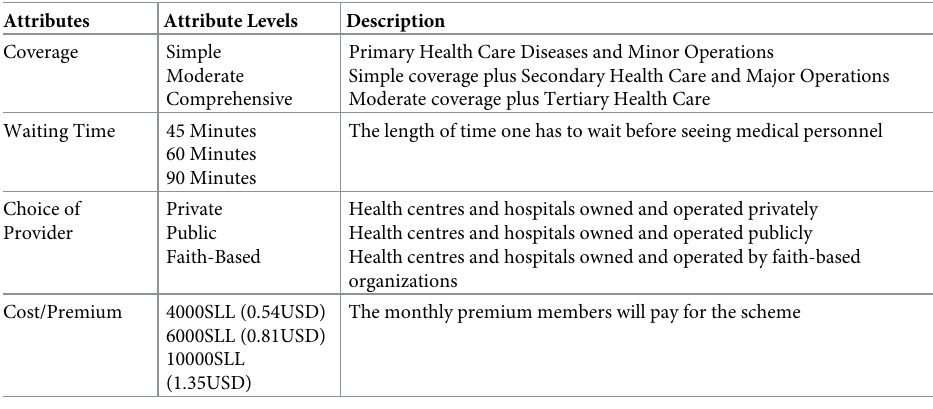
Table 1. Attributes and levels used in the